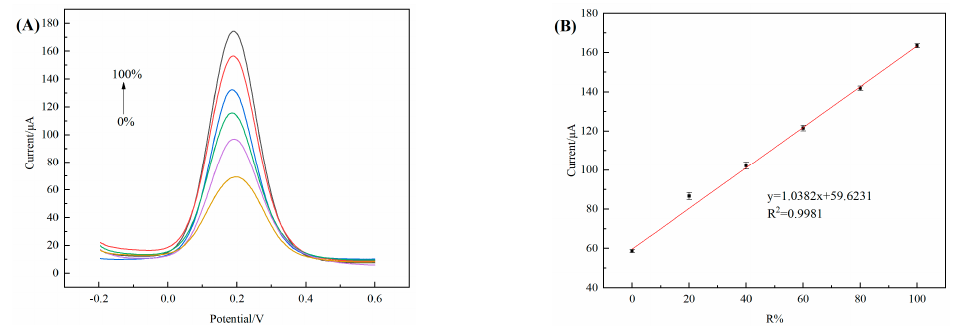
Figure 13. ( A ) DPV of 0.05 M R–/S–enantiomeric mixed solution containing diverse content of R– enantiomeric with 3D–rGO–CS–BSA/GCE in 0.1 M KCl containing 5 mM [Fe(CN) 6 ] 4 − /3 − solution; ( B ) linear relationship between Ip and R–enantiomeric% in the enantio–enriched solution.